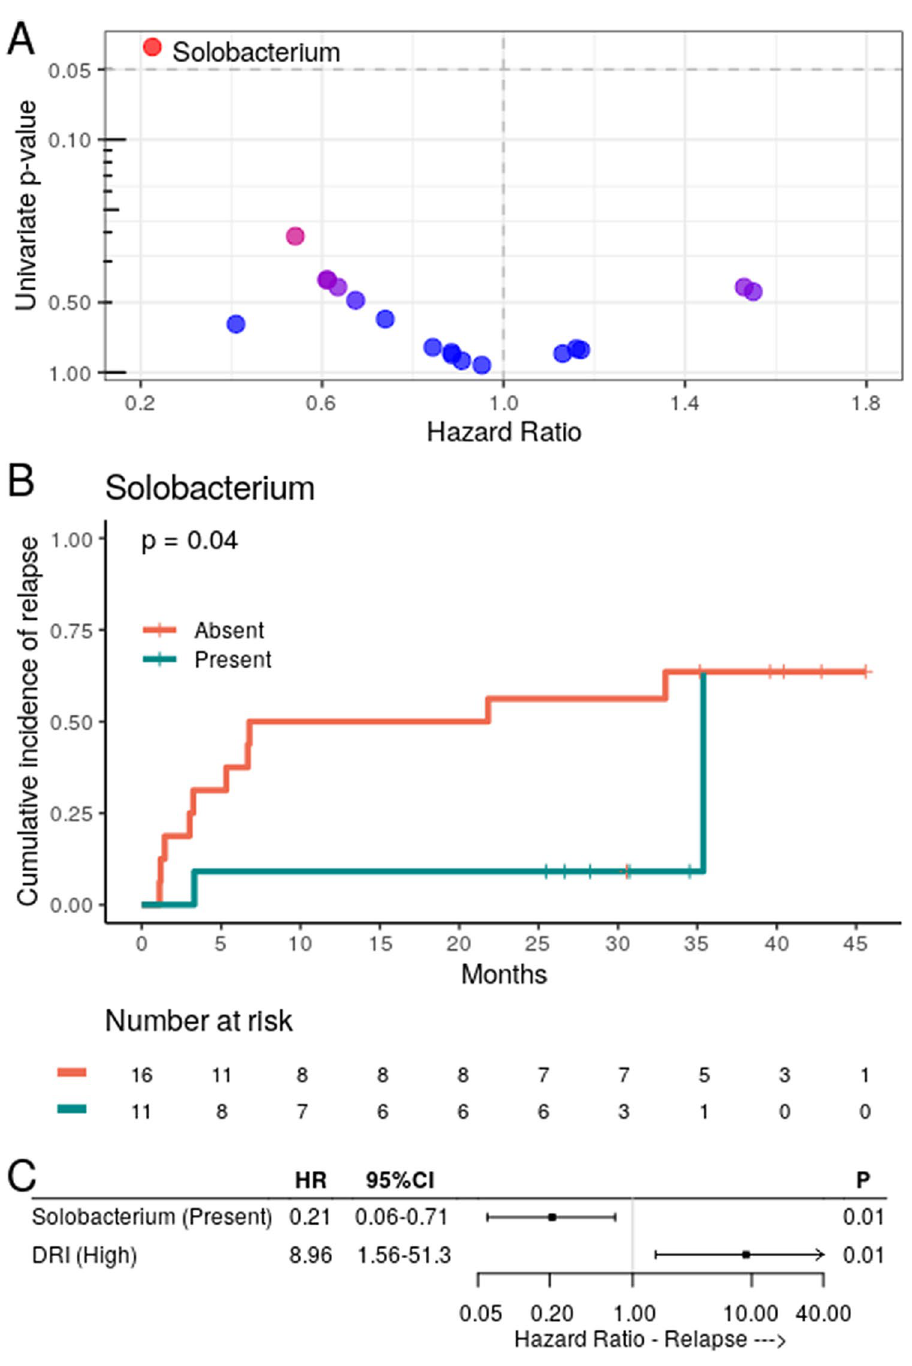
Figure 4. Solobacterium absence at preconditioning was associated with an increased risk of relapse in patients who underwent allo-HSCT. ( A ) Volcano plot for the univariate competing risk analysis of the association of relapse with the presence of specific genera at preconditioning ( P value versus hazard ratio). The Solobacterium data point is indicated as it was the only genus significantly associated with relapse ( P < 0.05). ( B ) Cumulative incidence of relapse with patients (n = 27) stratified by Solobacterium presence. ( C ) The DRI-adjusted hazard ratio for the association of Solobacterium presence at preconditioning and relapse (n =